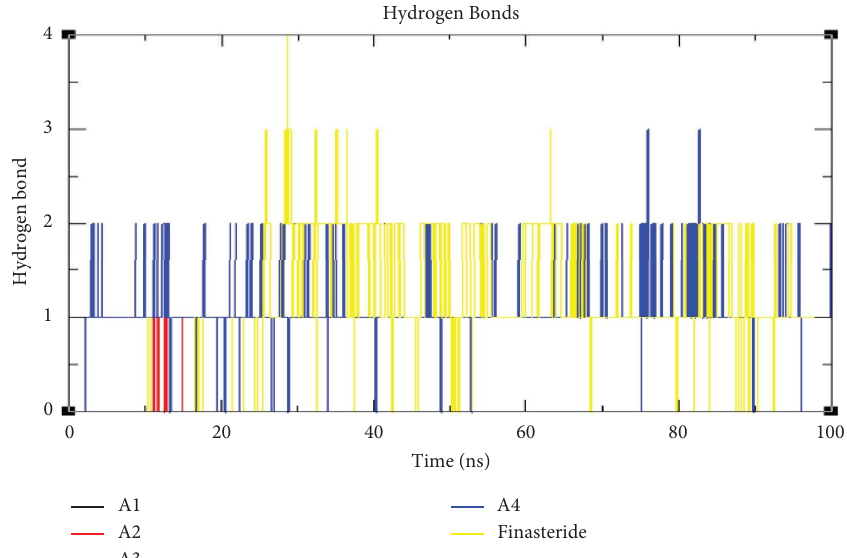
Figure 9: Te number of hydrogen bond interactions of the protein–ligand complexes during the 100ns simulations for the fve ligands comprising the hits (A1, A2, A3, and A4) and fnasteride. Table 6: Te van der Waals interactions energy ( Δ G vdW ), electrostatic energy ( Δ G ele ), polar solvation energy ( Δ G pol,sol ), nonpolar solvation energy ( Δ G SASA ), and free energy of binding ( Δ G bind ) of the protein–ligand complexes. Complex Δ G vdW (kJ/mol) Δ G ele (kJ/mol)